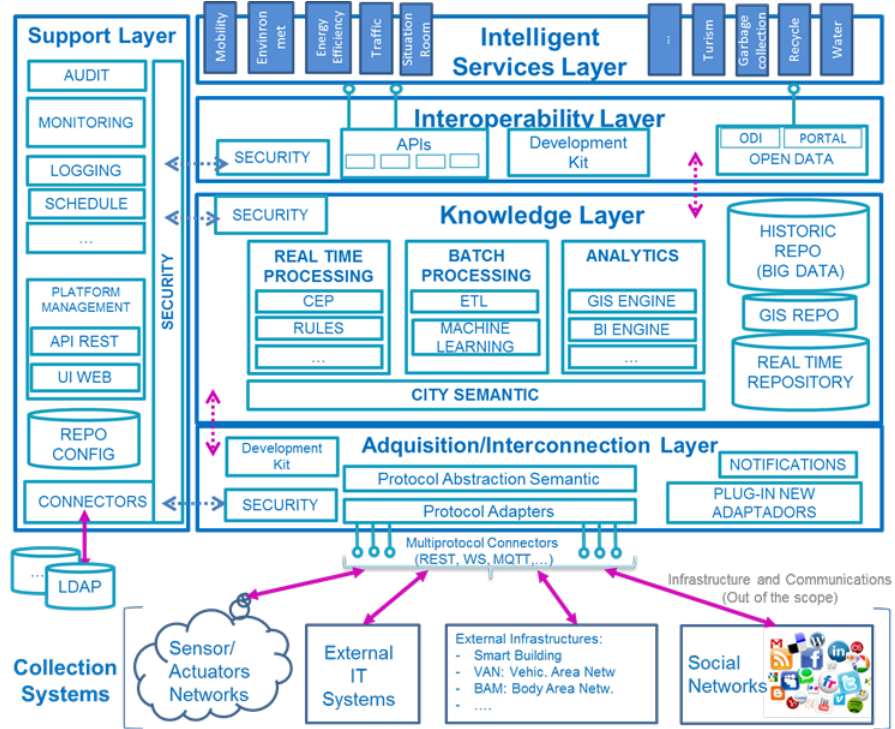
Figure 3. UNE 178104 Reference Architecture [11]. (Source: UNE 178104:2017 Sistemas Integrales de Gestión de la Ciudad Inteligente. Requisitos de interoperabilidad para una Plataforma de Ciudad Inteligente (https://tienda.aenor.com/norma-une-178104-2017-n0059471). Reproduced with the authorisation of AENOR.